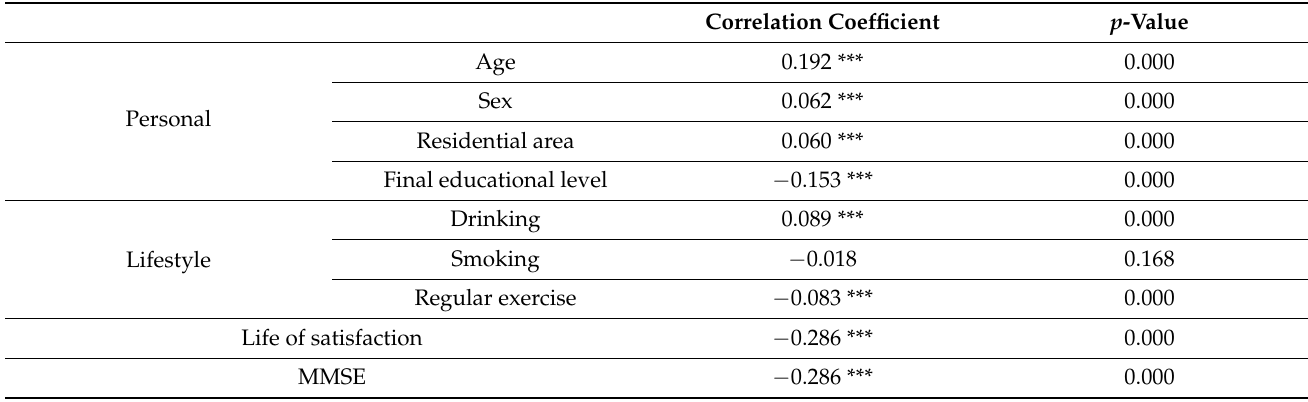
Table 2. Correlation between depression and factors.